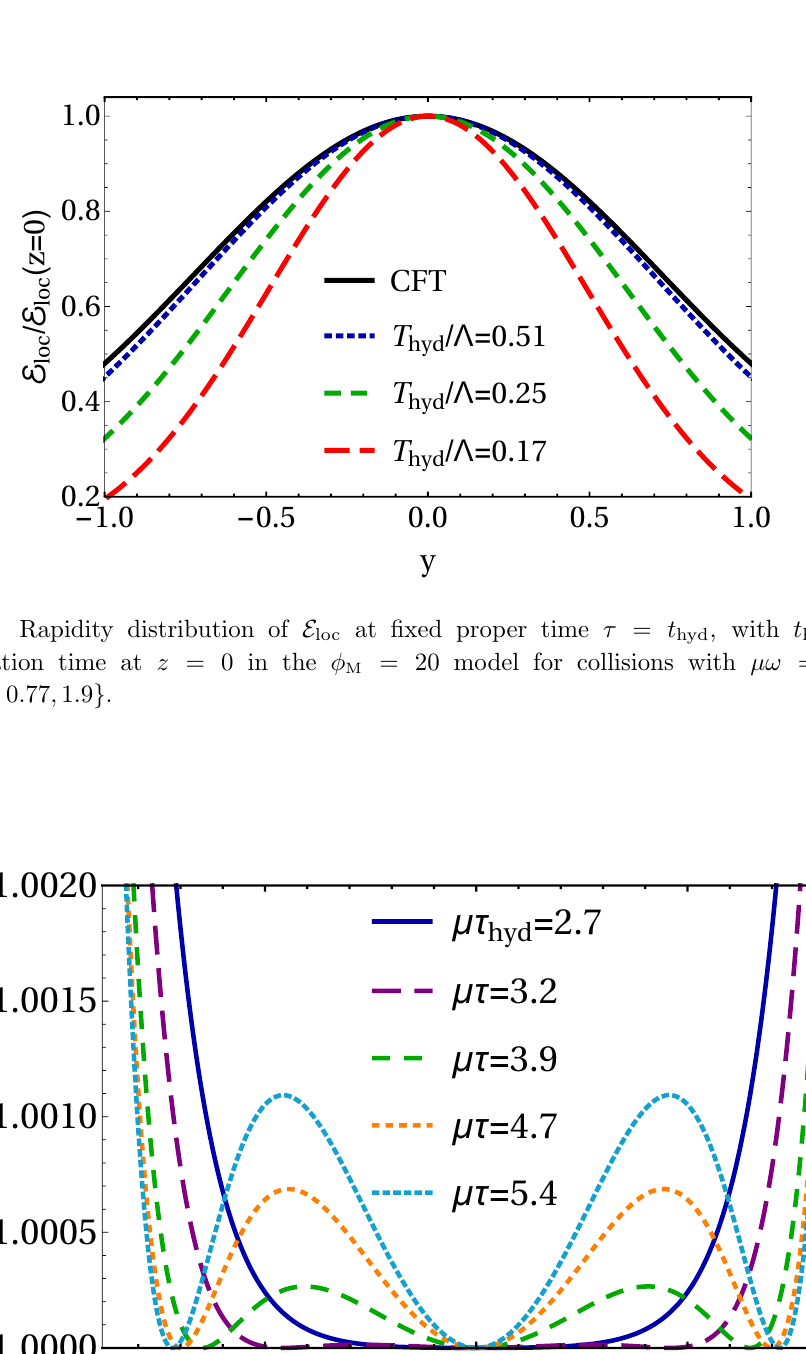
= 20 and (cid:22)= (cid:3) = 0 : 29. M